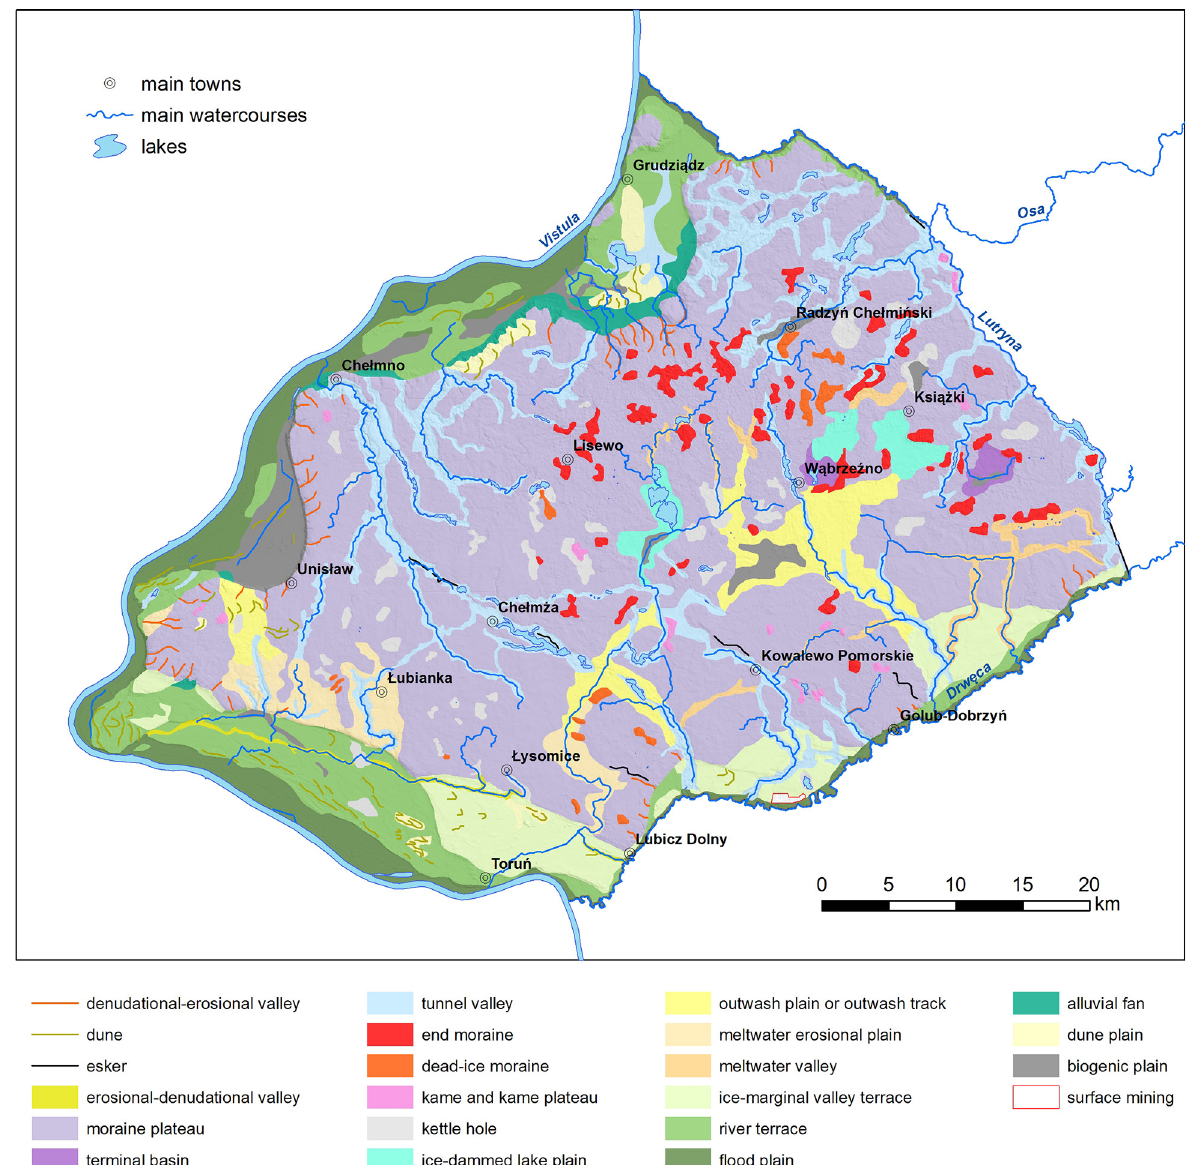
Fig. 3. Geomorphological map based on Molewski and weckwerth